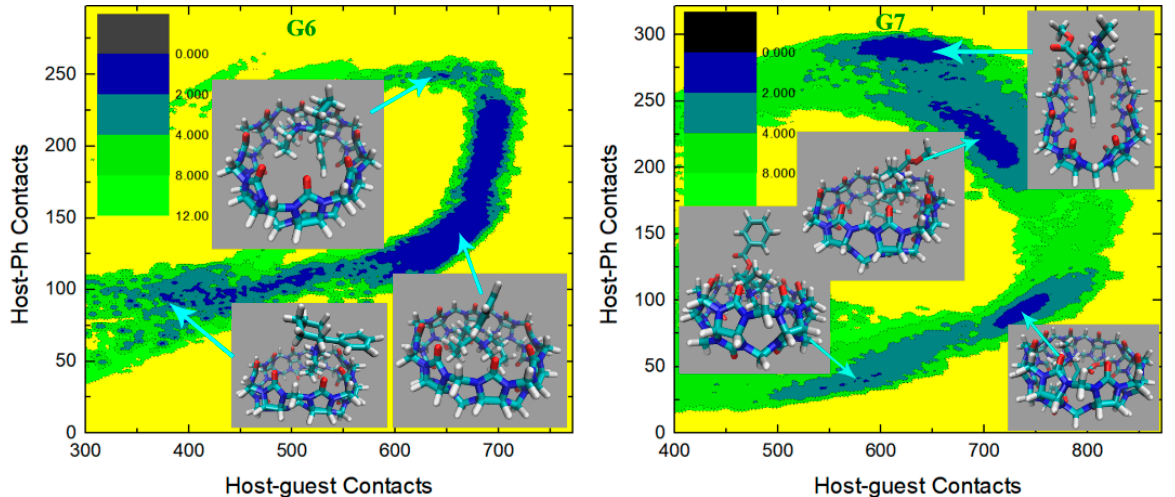
− Figure 6. 2D Ph C C free energy surfaces in kcal/mol obtained under the GAFF2 force fi eld. Figure 6. 2D C − C Ph free energy surfaces in kcal/mol obtained under the GAFF2 force